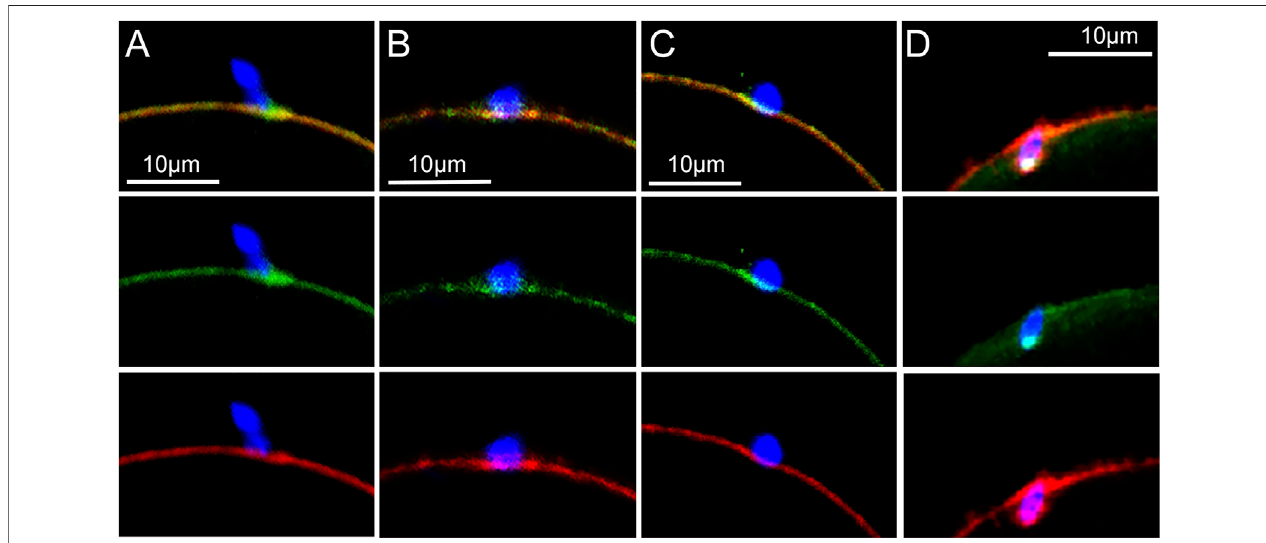
FIGURE 1 | Localization of β -catenin at the sperm binding site.Oocytes fi xed at different stages of fertilization were labeled with anti- β -catenin (green) and Alexa Fluor-568 phalloidin (red) aswell asHoechst 33342 (blue). (A) Recentlybound sperm. (B) bound sperm with microvilli exhibiting β -catenin labelling. (C) β -catenin plaque colocalizing with the actin layer. (D) sperm undergoing incorporation into the ooplasm with a single bright patch of β -catenin remaining. Images were selected from 30 oocytes recovered from 4 females. Magni fi cation is indicated by the bar.